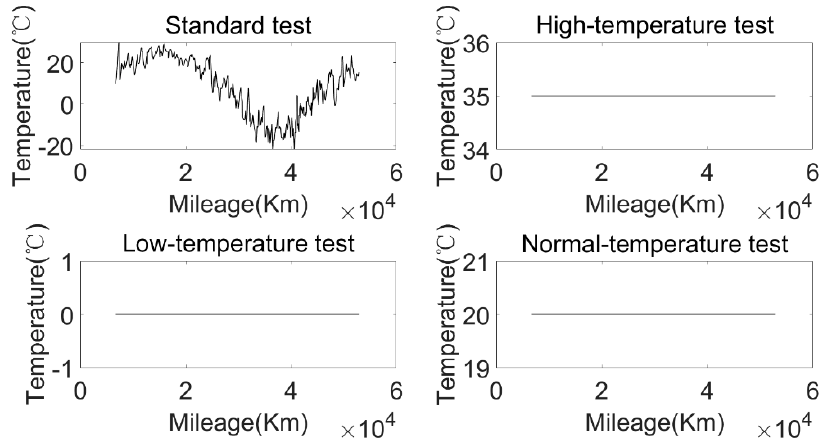
Figure 24. The relationship between environmental temperature and mileage under four different test environments.